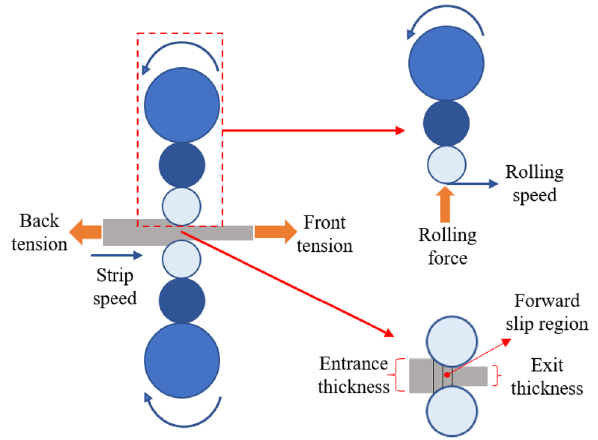
Fig. 5 Process parameters of the fifth